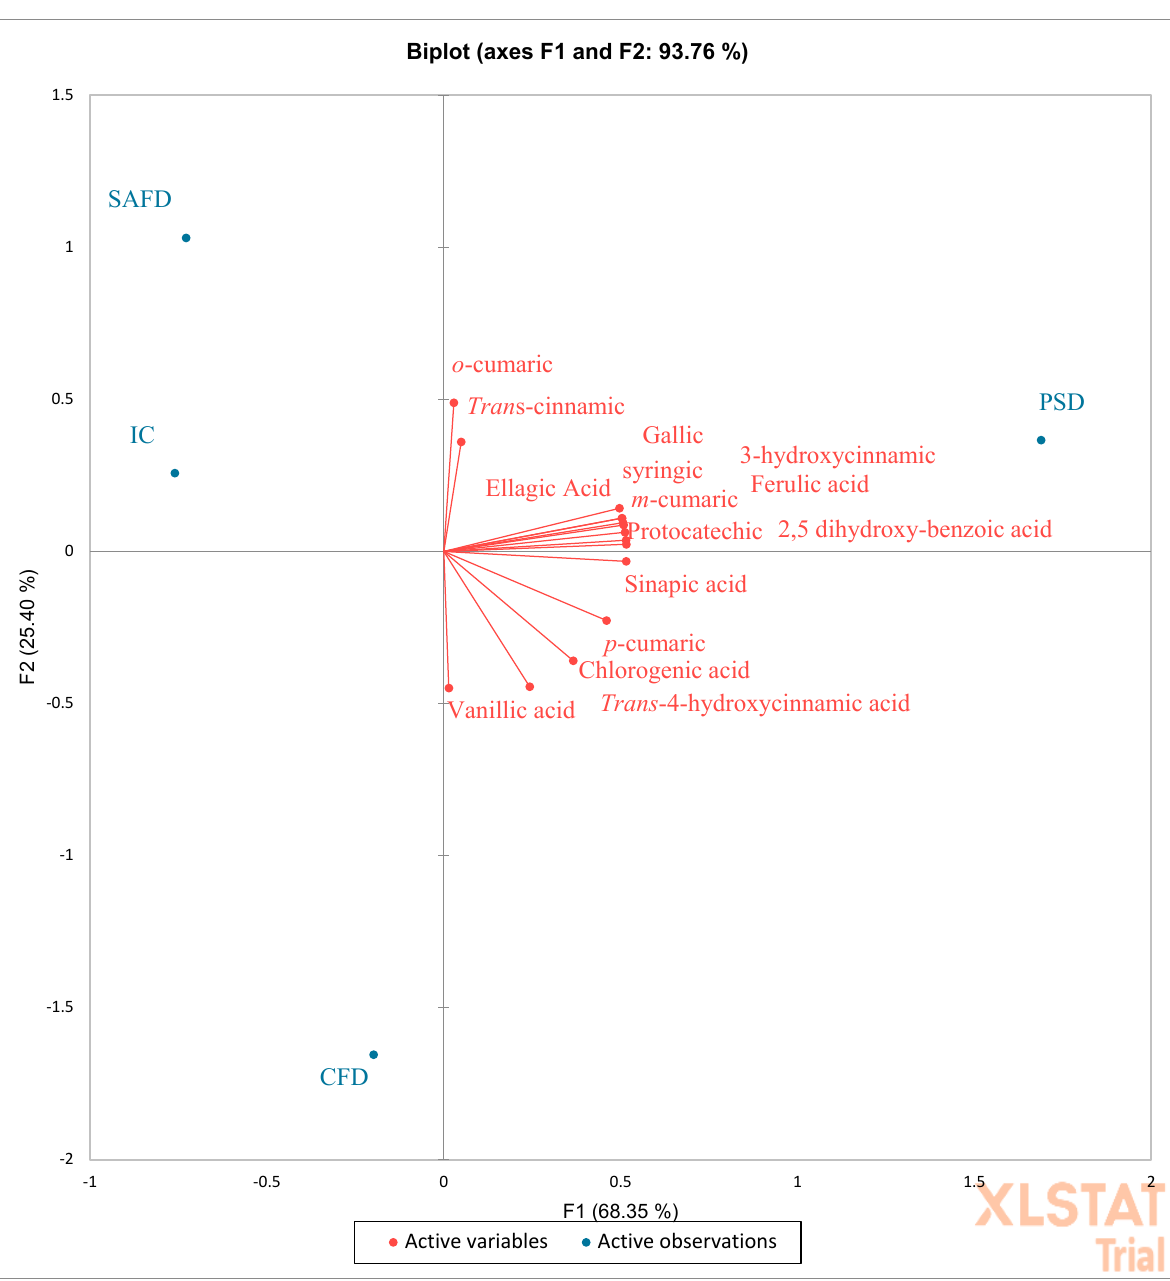
Figure 5. PCA (principal component analysis) diagram of single phenolic acids contained in the peels of different pomegranate cultivars dried differently. PSD (spray-dried Wonderful peel, experimental data); CFD (Calabrian Wonderful peel freeze-dried, experimental data); SAFD (South African Wonderful peel freeze-dried, literature data); IC (Indian cultivar peel freeze-dried, literature data).